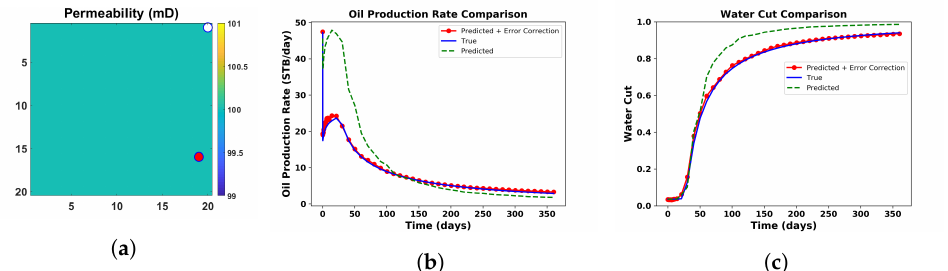
Figure 25. ( a ) Test case with a producer well location at (16,19). ( b ) Comparison of the oil production rate and ( c ) comparison of water cut, predicted using global the PMOR method alone using 100 sam- ples (dotted green line) and after the implementation of error correction model (red circled line) with the true solution (blue